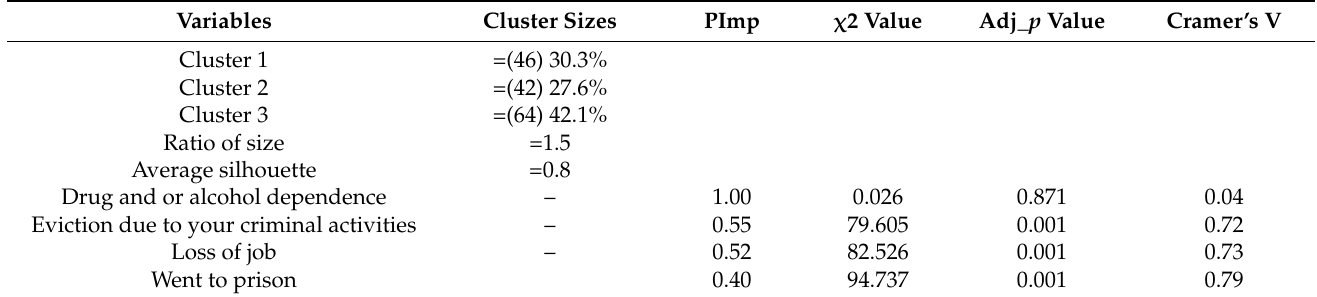
Table 6. The two-step cluster model that classifies the factors leading to homelessness according to the ratio of size, an average silhouette of the model, PImp values, χ 2 values, and variable-specific Cramer’s V